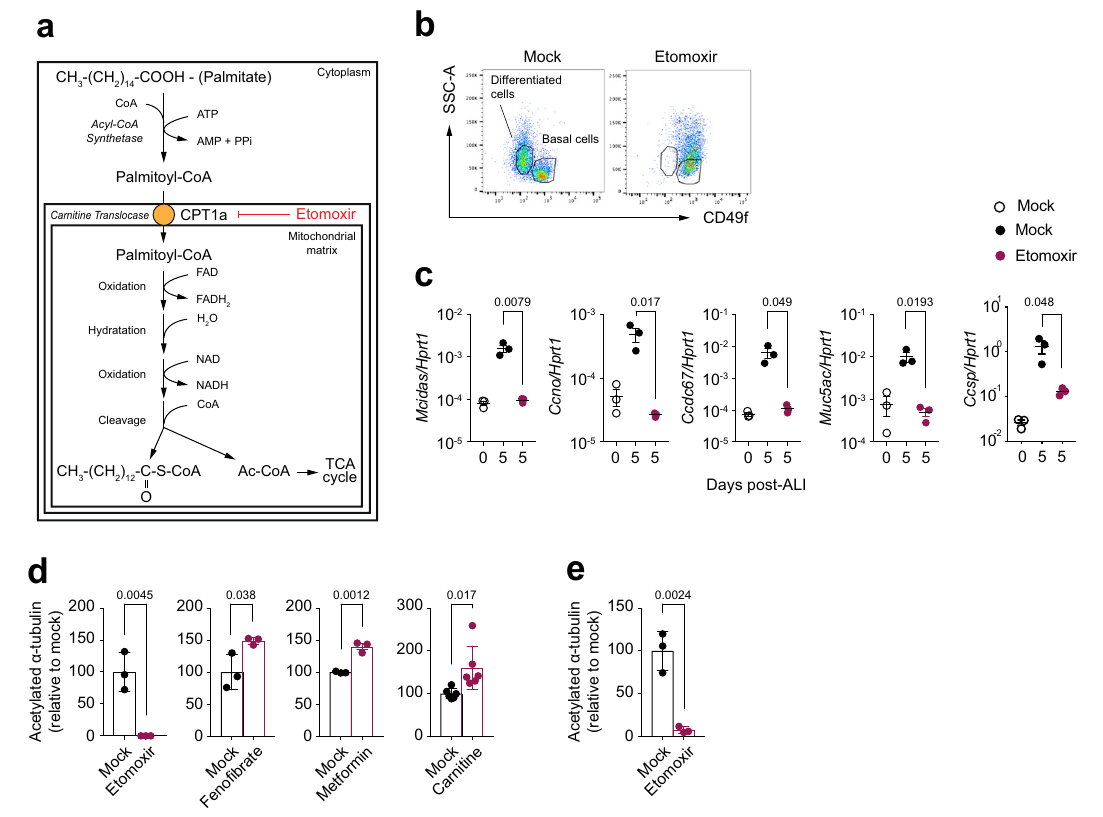
Fig. 2 | Modulation of FAO in fl uences epithelial cell differentiation. a Scheme representing fatty acid β -oxidation (FAO) of palmitic acid in the mitochondria and theroleofetomoxirasanirreversibleinhibitorofCPT1a. b Flowcytometryanalysis of basal and differentiated cells in mTEC cultures at ALI day 10, in presence or absence of etomoxir. Data show representative dot plots of fi ve independent experiments. SSC: side scatter. c mRNA expression levels of the indicated genes in mTECculturesatALIday0,orday5inthepresenceorabsenceofetomoxir.Values are normalized to Hprt1 . Data show mean+/ − SD and are representative of fi ve independent experiments. Statistics were performed using two-tailed unpaired Student ’ s t test; n =3biologicallyindependentsamples. d Fluorescencemicroscopy quanti fi cation of acetylated α -tubulinfrom entirewells of mTECcultures, grownin